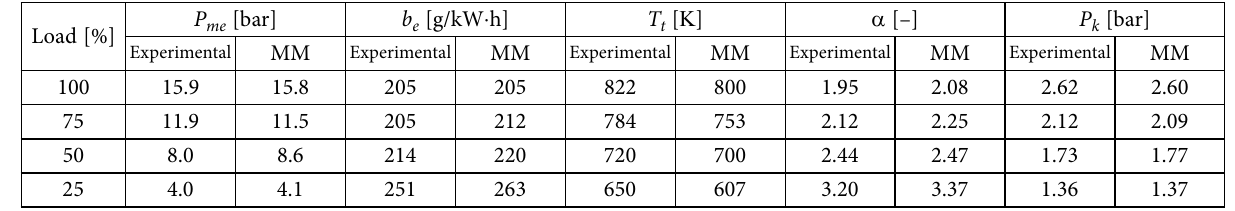
Table A3. Comparison of diesel engine SKL VDS 48/42 MM adequacy validation experiment and modelling results